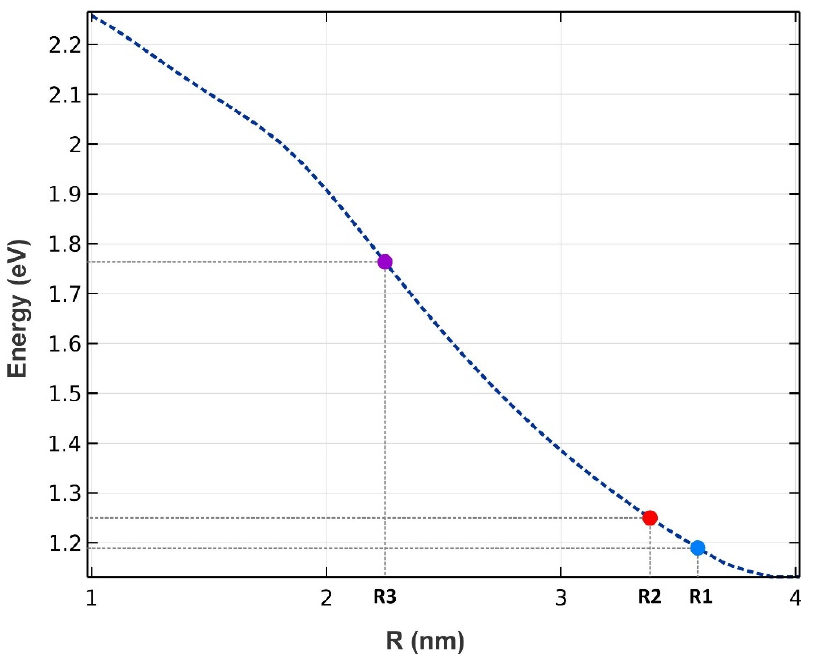
Figure 7. The energy difference between the excited states in the conduction band and the valence band (pump energies) as a function of the radii of the QDs. Three groups of QDs have been chosen (R1, R2, and R3).